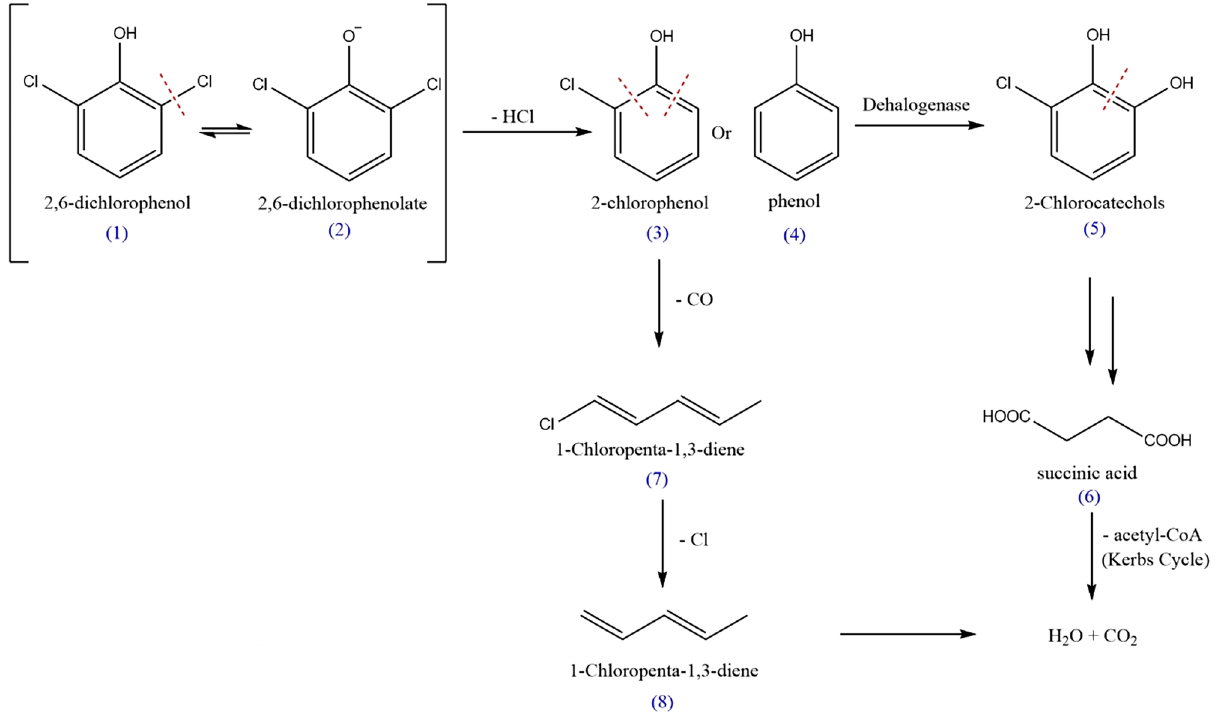
Figure 6. Proposed pathway of the degradation of 2,6-DCP by Trichoderma longibraciatum.